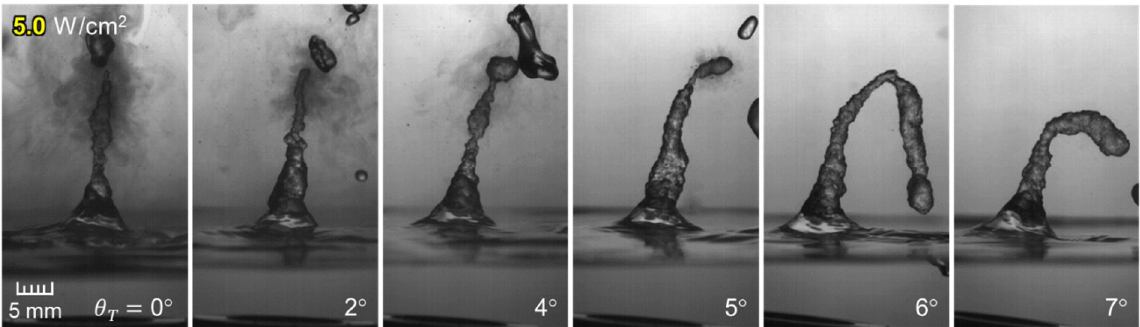
Figure 3. Images of liquid fountain obtained for different transducer setting angles at input power density of 5.0 W/cm 2 . density of 5.0 W/cm 2